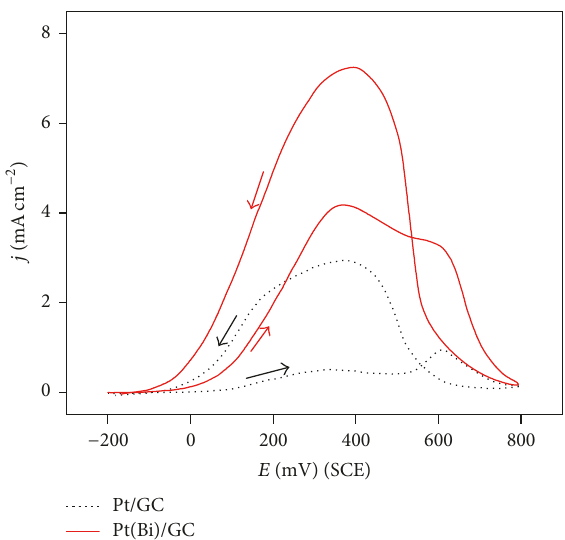
Figure 3: CVs for oxidation of 0.125 M HCOOH in 0.1M H 2 SO 4 on Pt/GC and Pt(Bi)/GC electrode at 50mV s – 1 and 𝜛 = 1500 rpm.